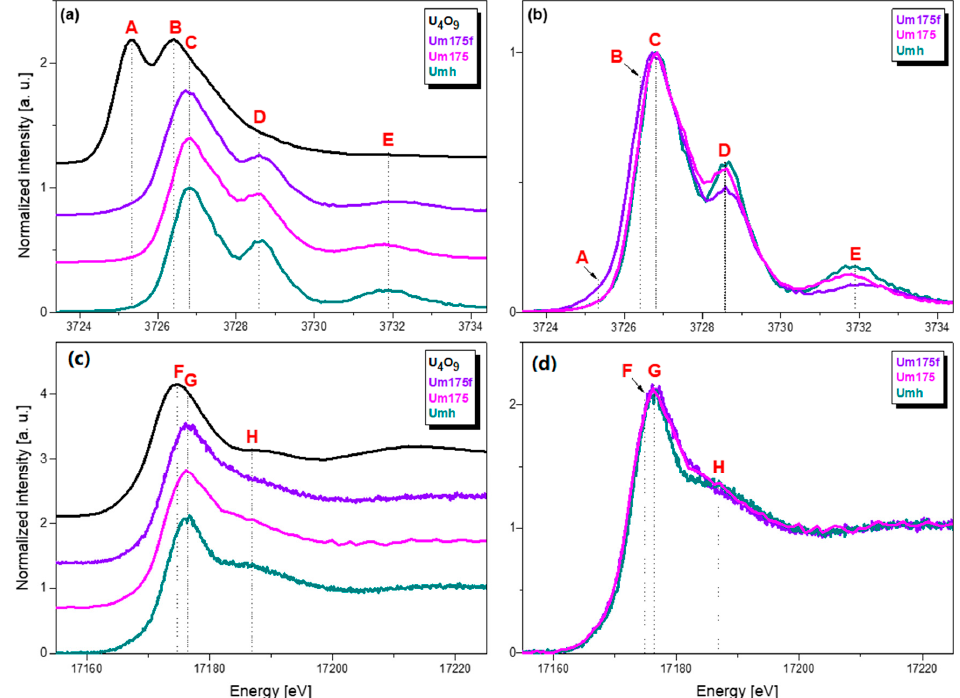
Figure 10. U M4 ( a , b ) and U L3 ( c , d ) edge HR-XANES spectra of U 4 O 9 (black), Um175f (violet), Um175 Figure 10. U M4 ( a,b ) and U L3 ( c,d ) edge HR-XANES spectra of U 4 O 9 (black), Um175f (violet), (magenta) and Umh Um175 (magenta) and Umh (marine).